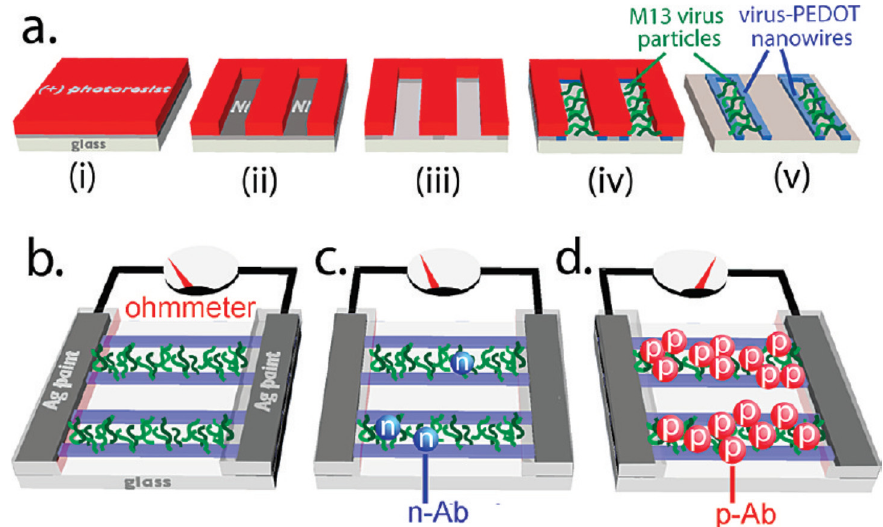
Figure 8. Virus ‐ templated nanowires based electrical biosensor: ( a ) schematic preparation of virus ‐ Figure 8. Virus-templated nanowires based electrical biosensor: ( a ) schematic preparation of polymer nanowires, ( b ) detection mechanism of electrical biosensors, and ( c , d ) detection of antibodies virus-polymer nanowires; ( b ) detection mechanism of electrical biosensors; and ( c , d ) detection of (Reprinted with permission from [182], published by American Chemical Society, 2010). antibodies (Reprinted with permission from [182], published by American Chemical Society,